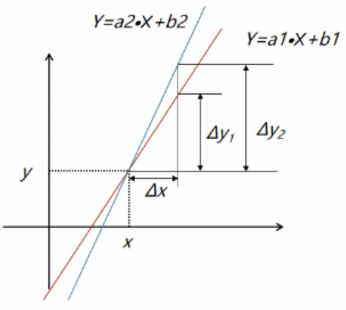
Figure 3. Schematic diagram of this